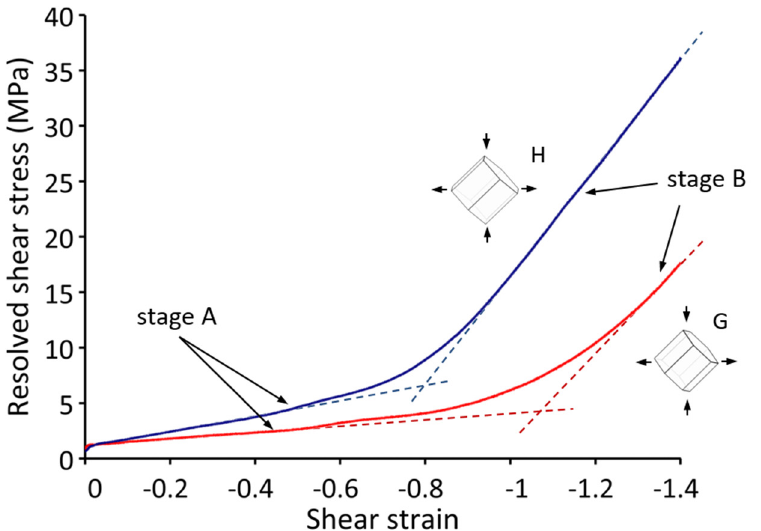
Figure 24. Resolved shear stress–shear strain curves of pure Mg single crystals of orientations G and H (shown up to a shear strain of − 1.4) corresponding to the true stress–strain curves in Figure 18.